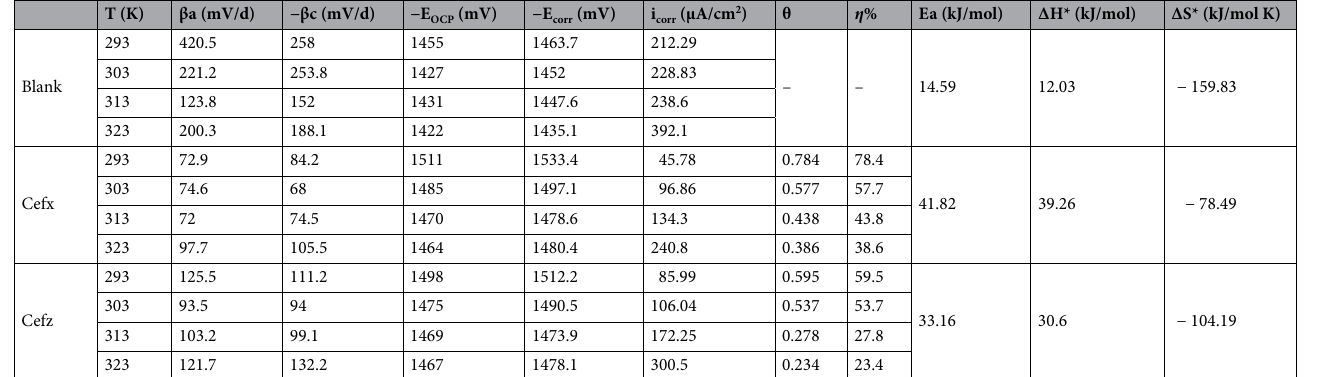
where i o corr and i corr are the corrosion current densities for blank and inhibited solutions, respectively. Figure 4 represents the PDP profiles of the Al in the pure 0.1 M NaOH and existence of different concentrations of Cefx (Fig. 4a) and Cefz (Fig. 4b). The results demonstrate that the greater value of I corr and the more positive value of the E corr (212.29 µA/cm 2 , − 1463.7 mV vs. Ag/AgCl) are observed in the inhibitor-free solution compared to (45.78 µA/cm 2 , − 1533.4 mV vs. Ag/AgCl) and (85.99 µA/cm 2 , − 1512.2 mV vs. Ag/AgCl) in the presence of 300 ppm from Cefx and Cefz, respectively. Furthermore, the values of E corr for all studied concentrations of both drugs are slightly shifted to negative direction compared to inhibitor-free solution, this means that the used drugs are cathodic ones, that mainly inhibit the cathodic reduction reaction of H 2 O through the retarda- tion of the cathodic polarization and decreasing the corrosion current density without any effect on the anodic polarization 44 . The multistep electrochemical process of anodic dissolution of Al in the alkaline solution has been summarized as follows 40,45 :